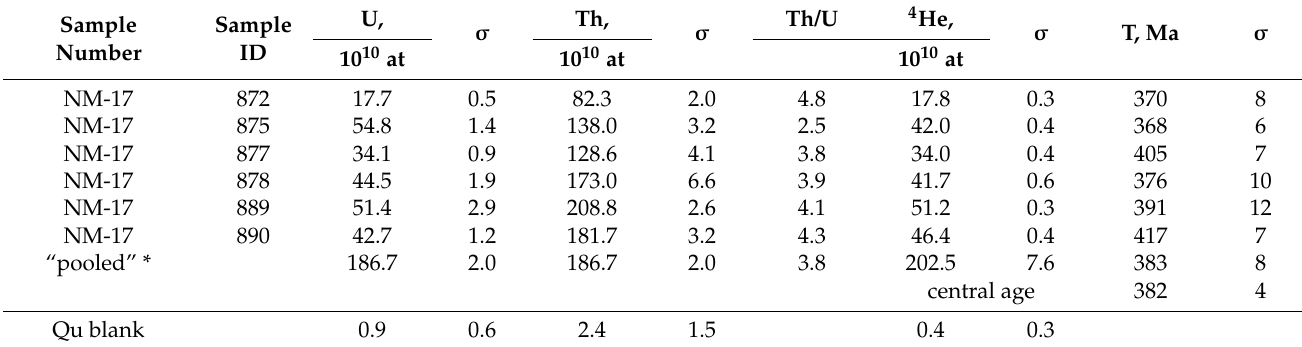
Table 2. Results of U-Th-He dating of pyrite from the Novogodnee-Monto